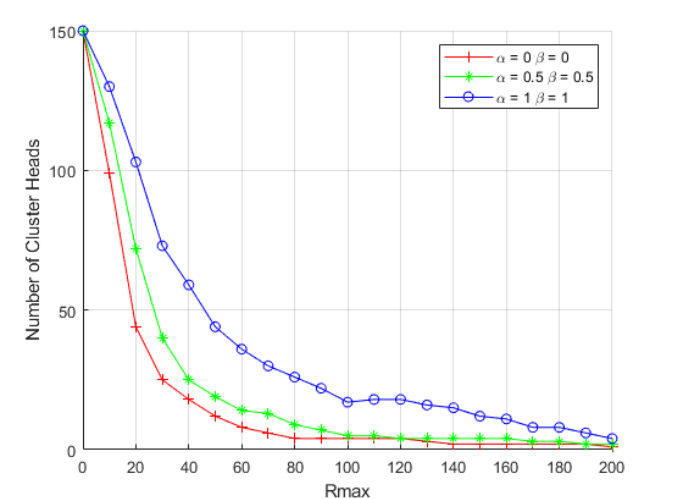
Figure 7. Number of Clusters Produced in the Network.